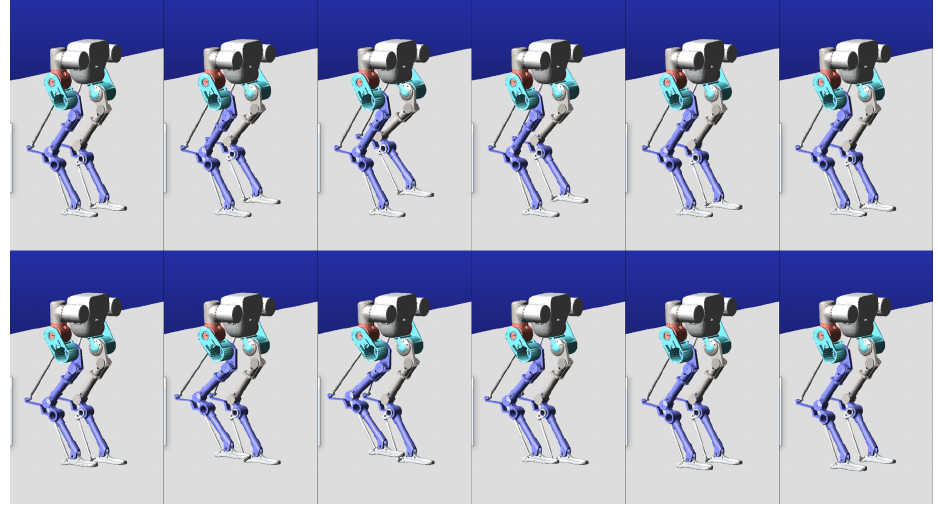
Figure 4. Step simulation. In the simulation, the robot steps at a speed of 4 mm/ms. The above figure shows two steps in intercepting the robot’s